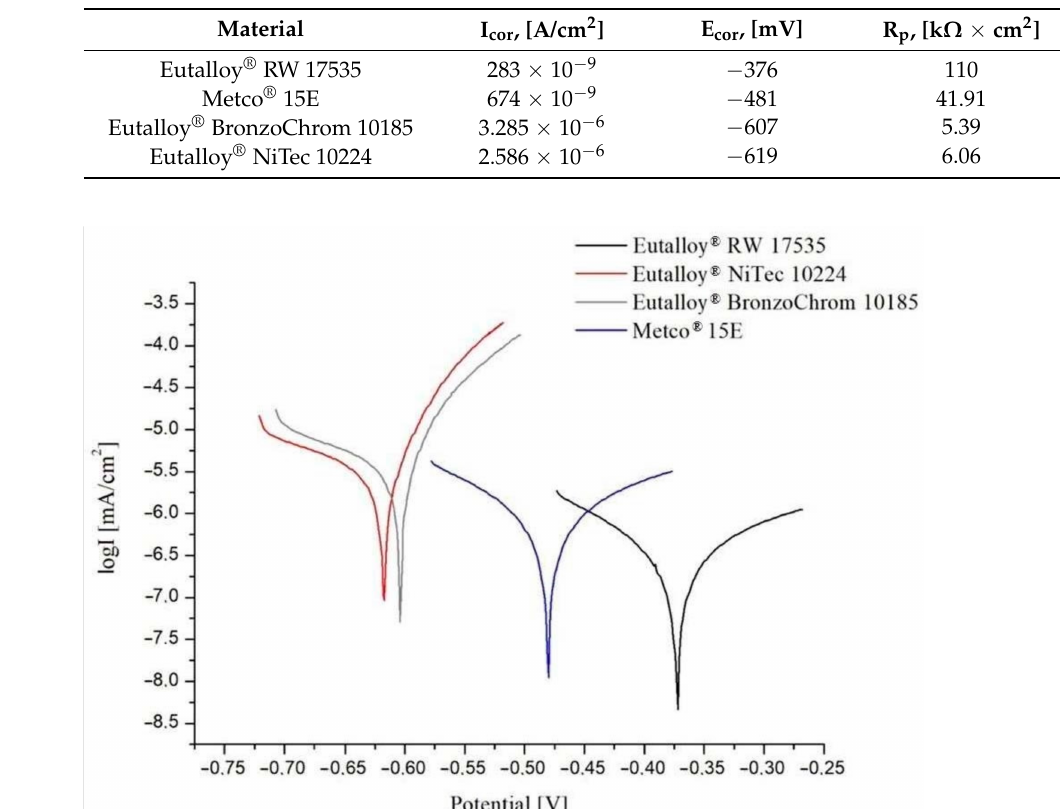
Table 9. Results of potentiodynamic tests for examined specimens.